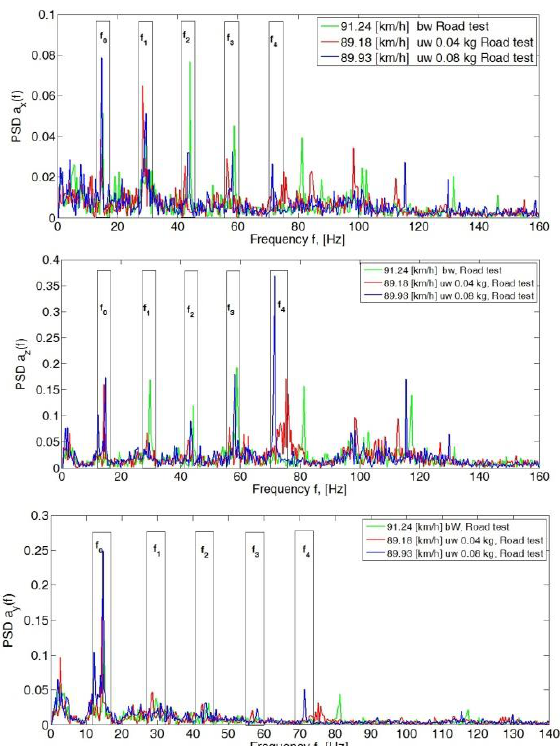
Figure 8. Power spectral density graph of the body acceleration signal for a speed of 90 km/h.